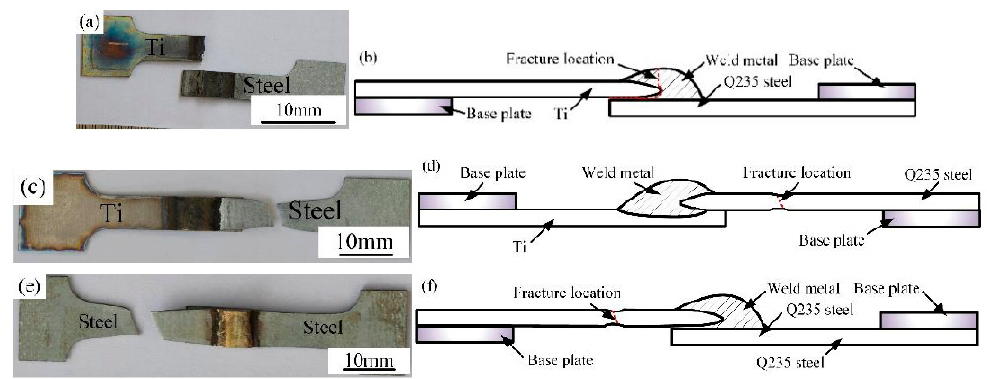
Figure 10. Fracture modes of the joints; ( a – b ) joint I (sample #1), ( c – d ) joint II (sample #2), ( e – f ) joint III (sample #3).